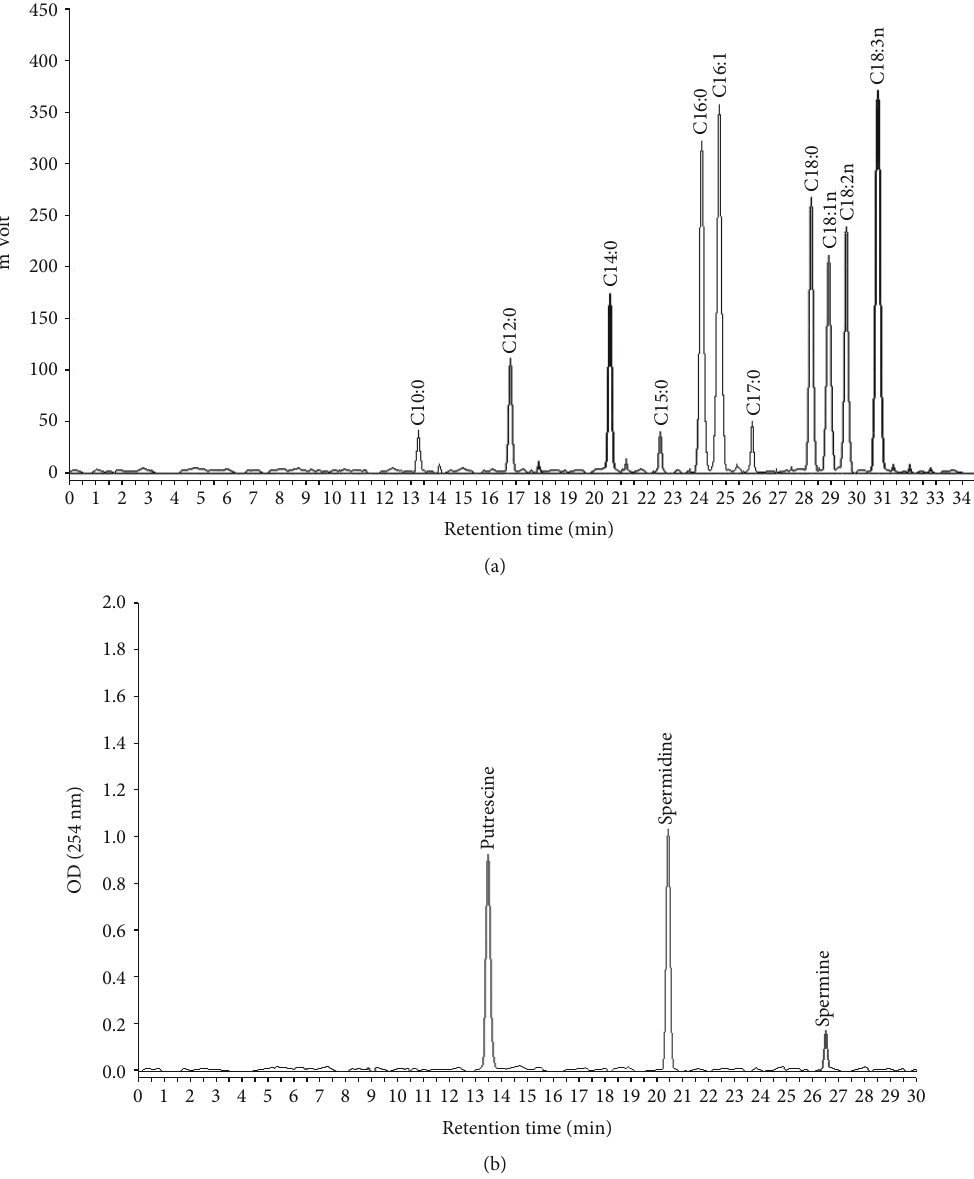
Figure 1: GC chromatogram of Fatty Acids (a), and HPLC chromatogram of Polyamines (b) in pomegranate peel. C10: Capric acid; C12: Lauric acid; C14: Myristic acid; C15: Pentadecylic acid; C16: Palmitic acid; C17: Margaric acid; C18: Stearic acid; C16:1: Palmitoleic acid; C18:1: Oleic acid; C18:2: Linoleic acid and C18:3 Linolenic